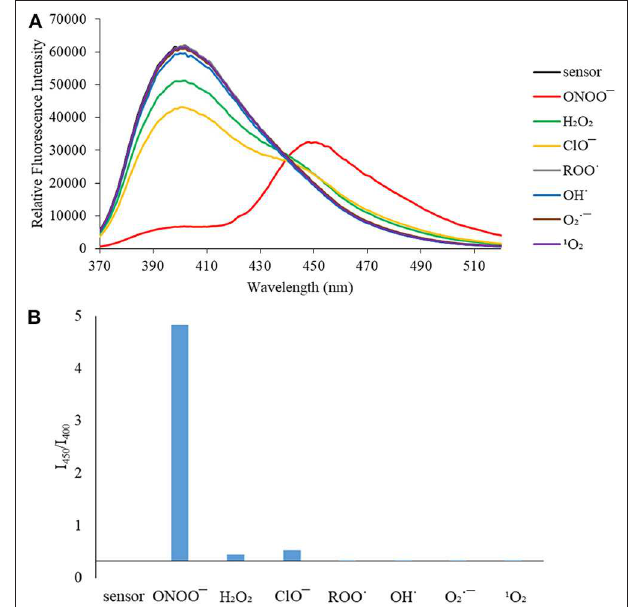
FIGURE 1 | (A) Emission spectra for 7-hydroxcoumarin-3-carboxylic acid (5 µ M), CM (5 µ M), CL (5 µ M), and CE (5 µ M) in PBS buffer, pH = 7.4 at 25 ◦ C. Fluorescence intensities were measured with λ ex = 340 (bandwith: 20) nm on a BMG Labtech CLARIOstar ® plate reader. (B) Emission spectra for 7-hydroxcoumarin-3-carboxylic acid (5 µ M), and CM (5 µ M), CL (5 µ M), and CE (5 µ M) in the presence of ONOO − (50 µ M) in PBS buffer, pH = 7.4 at 25 ◦ C. Fluorescence intensities were measured with λ ex = 340 (bandwith: 20) nm on a BMG Labtech CLARIOstar ® plate reader.